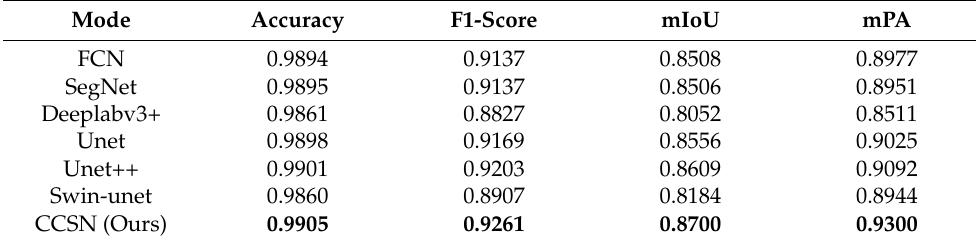
Table 8. Results of different networks by CCD.